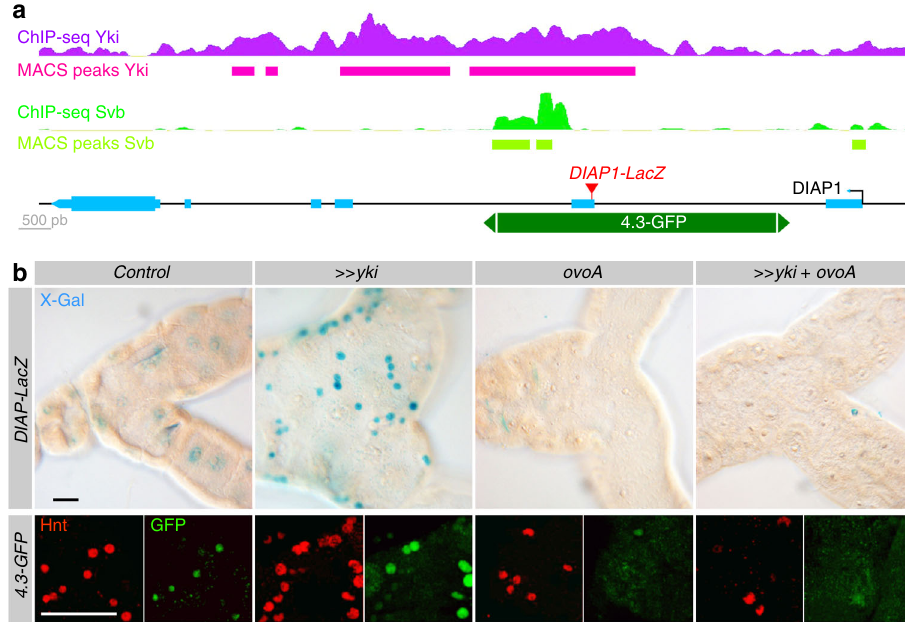
Fig. 6 Svb interacts with Yki to regulate DIAP1 expression. a Drawing of the DIAP1 locus. Exons are represented in cyan, the 4.3 enhancer in dark green and the insertion site of the DIAP1-LacZ reporter is in red. In vivo ChIP-seq pro fi les and MACS peaks bound by Svb and Yki are indicated in green and magenta, respectively. b esg ts was used to drive the expression of yki , svb REP ( ovoA ), and yki together with svb REP in RNSCs. The expression of DIAP1 was followed by the activity of DIAP1-lacZ (X-Gal staining, top panel). Expression of the 4.3-GFP enhancer of DIAP1 (bottom panel) was followed by immuno-staining against GFP (green) and Hindsight (Hnt, red) revealing the in fl uence of Yki and/or OvoA on RNSCs. Scale bar is 30 µ